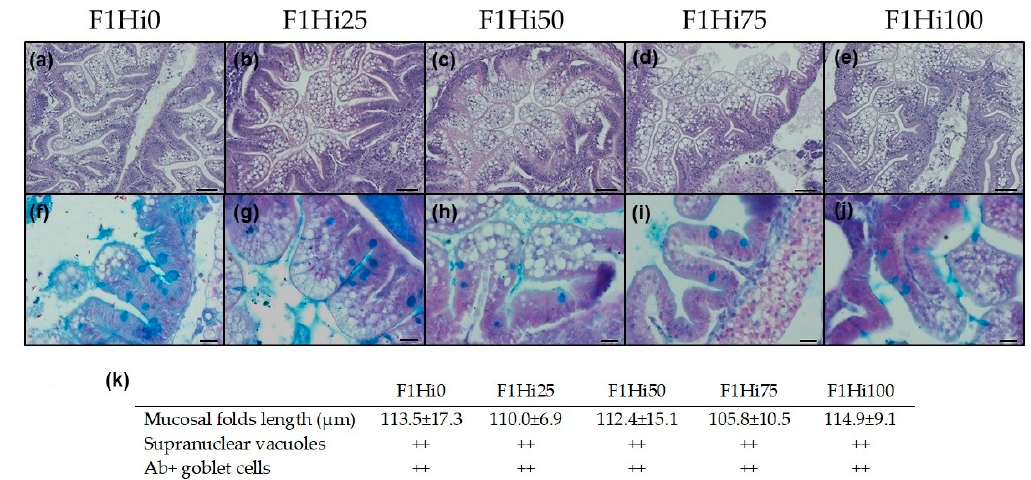
Figure 4. ( a – j ) Example of medium intestine histomorphology and ( k ) histological indexes (mucosal folds length, supranuclear vacuoles and Ab+ goblet cell abundance) measured in this gut tract of F1 zebrafish larvae fed diets including 0, 25, 50, 75 and 100% of BSF prepupae meal respect to fish meal (F1Hi0, F1Hi25, F1Hi50, F1Hi75 and F1Hi100 groups). Scale bars and staining: ( a – e ) 50 μ m, H&E; ( f – j ) 20 μ m, Ab. Letters: gc = Ab+ goblet cells. For histological indexes ( k ), values of mucosal folds length are shown as mean ± standard deviation ( n = 15). Scores: supranuclear vacuoles + = scattered, ++ = abundant; Ab+ goblet cells + = 0 to 3 per villus, ++ = 4 to 6 per villus, + + + = more than 6 per villus. No significant differences were detected among the experimental groups.